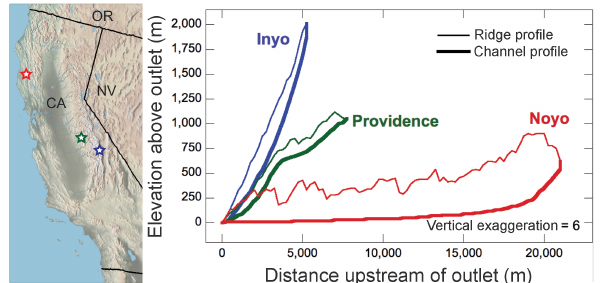
Figure 1. Study site locations and comparison of channel and ridge profiles. Left: location map of study catchments in California, USA. Right: elevation longitudinal profiles of the lowest point at each travel distance (i.e., the main-stem channel) and the highest point at each travel distance (referred to here as the ridge profile). The longest and shortest travel distances in each catchment are the points where the two profiles meet. The channel and ridge profiles enclose all paired values of elevation and travel distance for each catchment. Differences in catchment relief and size across the sites produce distinct populations of paired values. The ratio of elevation to travel distance is the mean slope along a path from the source to the catch- ment outlet. Thus, the catchments also harbor distinct populations of mean